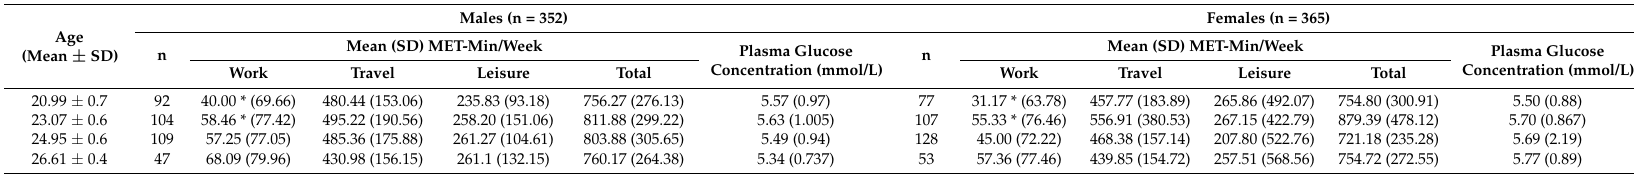
Table 1. Descriptive statistics for MET-min (metabolic equivalent minutes) per week in work, leisure and travel domains and proportions of total physical activity with corresponding plasma glucose concentrations of each age group for 717 ELS young adults aged 18 to 28